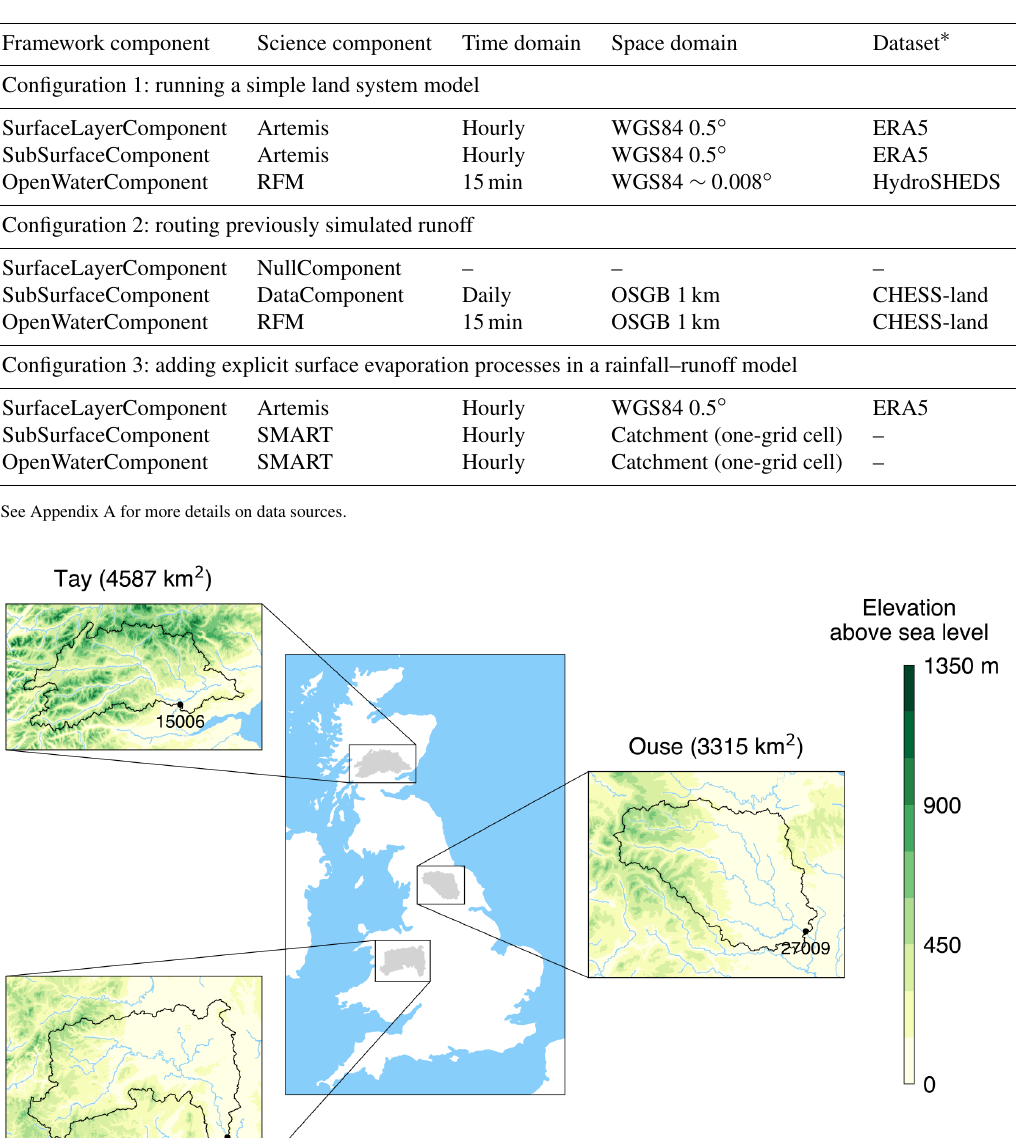
Table 2. Framework configurations.